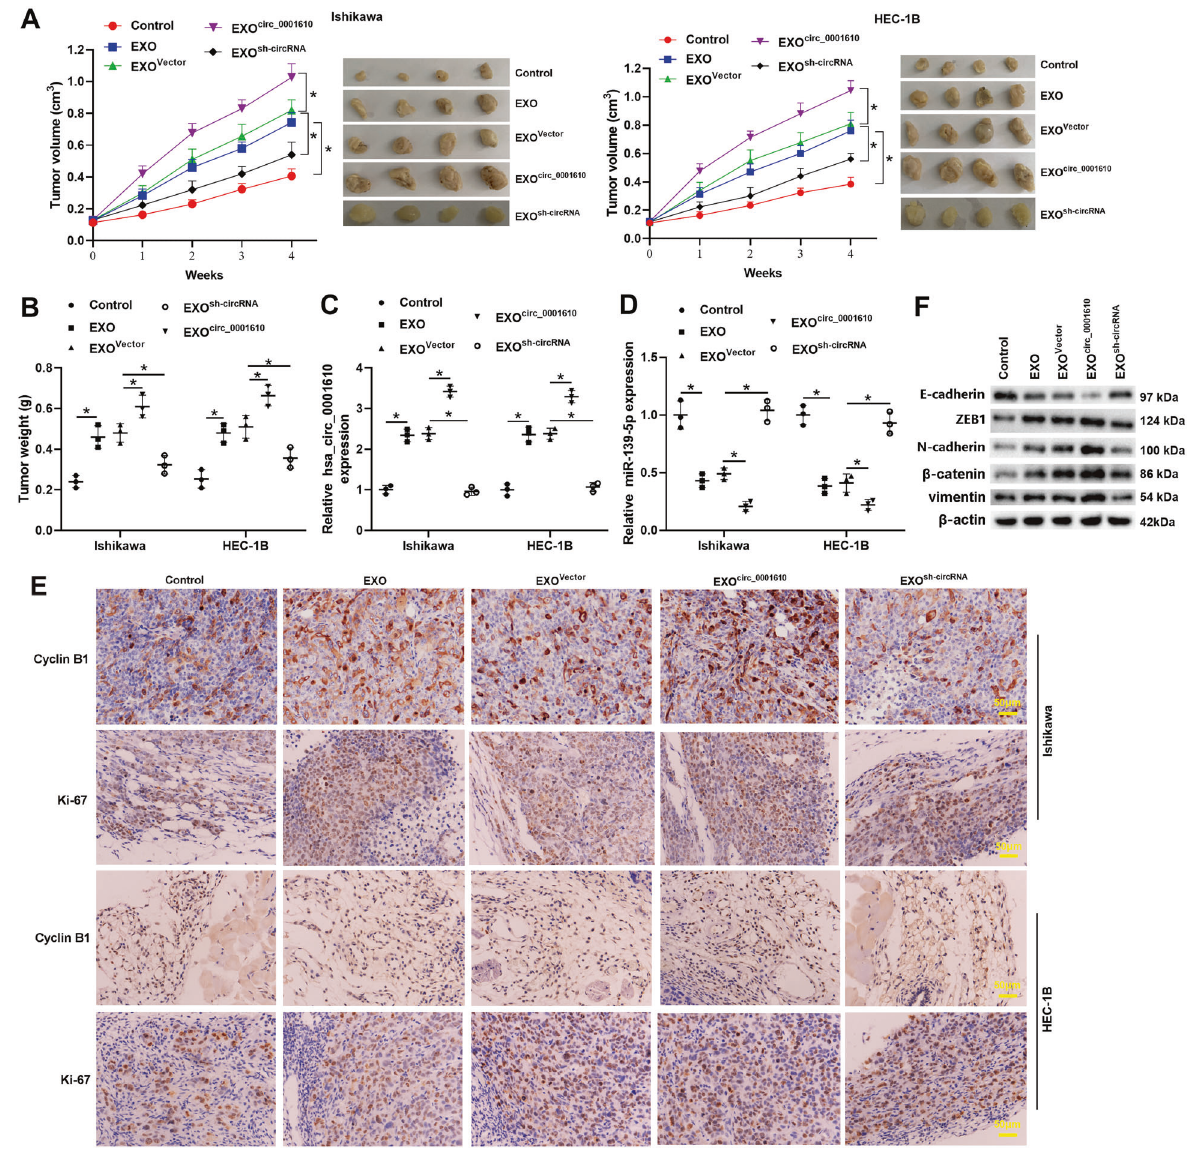
Fig. 6 Exosomal hsa_circ_0001610 weakened the radiosensitivity of EC cells in vivo. Ishikawa or HEC-1B cells were subcutaneously injected into the nude mice to establish the tumor xenograft model. When tumors grew to 100 mm 3 , mice were treated with irradiation (Control group; n = 6), irradiation + EXO (EXO group; n = 6), irradiation + EXOs that overexpressed hsa_circ_0001610 (EXO circ_0001610 ; n = 6), irradiation + the negative control of EXO circ_0001610 (EXO vector group; n = 6), and irradiation + EXOs that silenced hsa_circ_0001610 (EXO sh-circRNA ; n = 6). A The tumor volumes were measured every week after the beginning of local irradiation. Four weeks after the beginning of local irradiation, mice were sacri fi ced, the xenotransplanted tumors were collected and photographed. B Weight of tumors. The expression levels of C hsa_circ_0001610 and D miR-139-5p in tumors were measured. E Representative images of immunohistochemical staining for cyclin B1 and Ki-67 (Scale bar = 50 μ m). F The protein levels of E-cadherin, zinc fi nger E-box binding homeobox 1 (ZEB1), N-cadherin, β -catenin, and vimentin. * p <